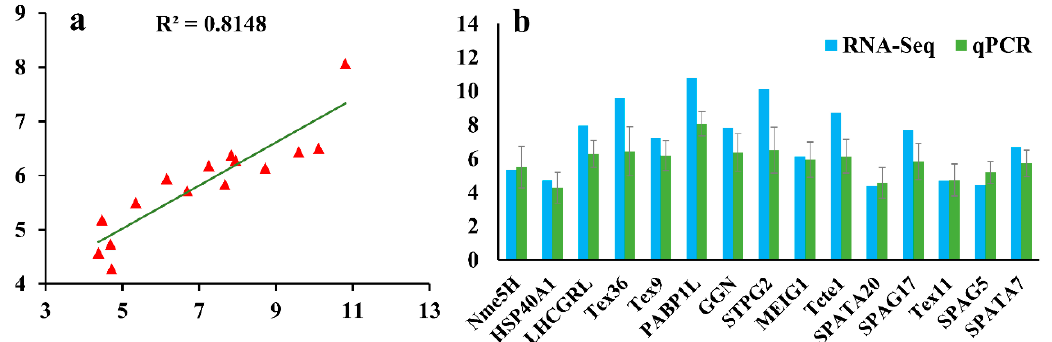
Figure 12. Validation of RNA-Seq data using qPCR. ( a ) Consistency of log 2 FoldChange (log 2 FC) between RNA-Seq ( X -axis) and qPCR assay ( Y -axis) is high (R 2 = 0.814) based on the 15 selected genes. ( b ) Log 2 FC of the selected DEGs by qPCR compared with RNA-Seq data. The log 2 FC values of qPCR are shown as the means ± standard error (SE).